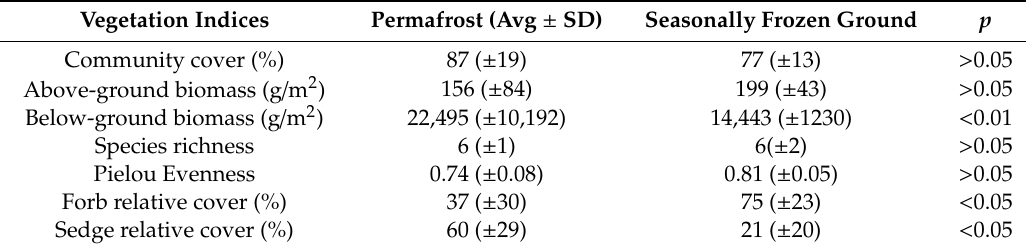
Table 3. Characteristics of vegetation in permafrost and seasonally frozen ground. N = 22, including sites in areas of permafrost and seasonally frozen ground. Permafrost (Avg ±